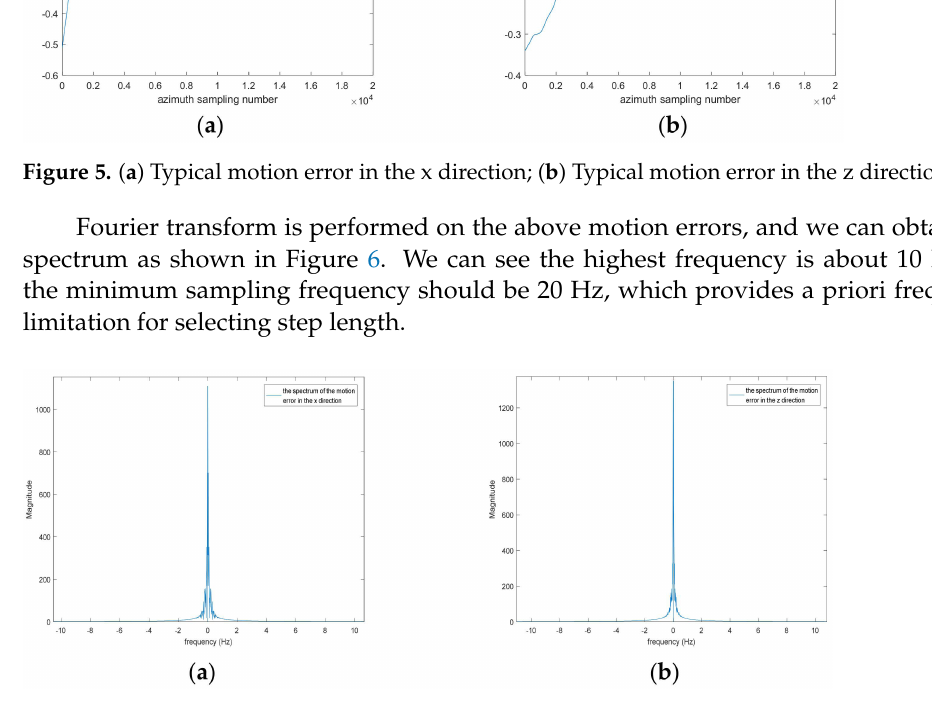
Figure 6. ( a ) Spectrum of motion error in x direction; ( b ) Spectrum of motion error in z